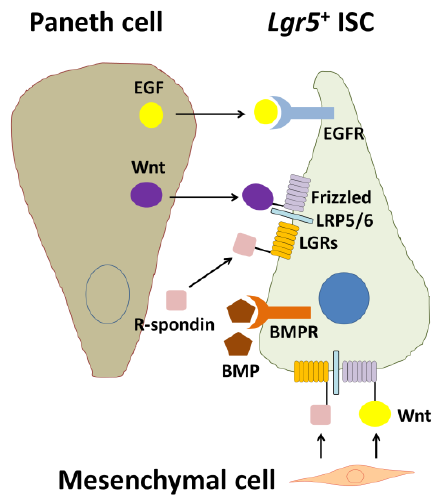
Figure 2. Biological interactions among an Lgr5 + intestinal stem cell (ISC), a Paneth cell, and a mesenchymal cell. EGF and Wnt are secreted from the Paneth cell and are essential for stemness of the Lgr5 + ISC. In contrast, BMP negatively regulates the stemness. For full Wnt activation, R-spondin-LGR signaling is required. In addition, Wnt and R-spondins, which are factors produced by mesenchymal cells, are also essential for maintenance of Lgr5 + ISCs. EGF: epidermal growth factor, EGFR: EGF receptor, BMP: bone morphogenetic protein, BMPR: BMP receptor, LRP5 / 6: lipoprotein receptor-related protein 5 / 6, LGRs: leucine-rich repeat-containing G-protein coupled receptors, Lgr5: leucine-rich repeat-containing G-protein coupled receptor 5 [9]. The LGR5 protein is a member of the LGR family. LGR proteins form membrane-spanning